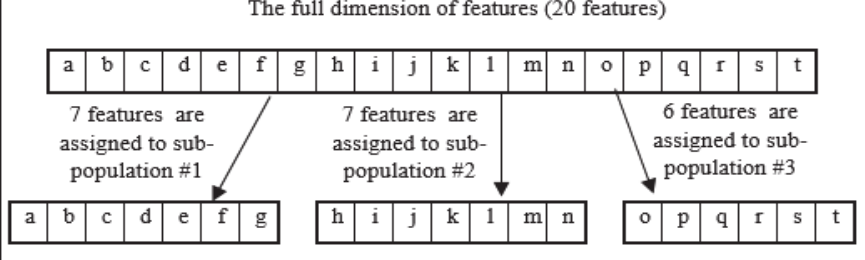
Figure 3. Subsets of features into sub ‐ populations assignment .